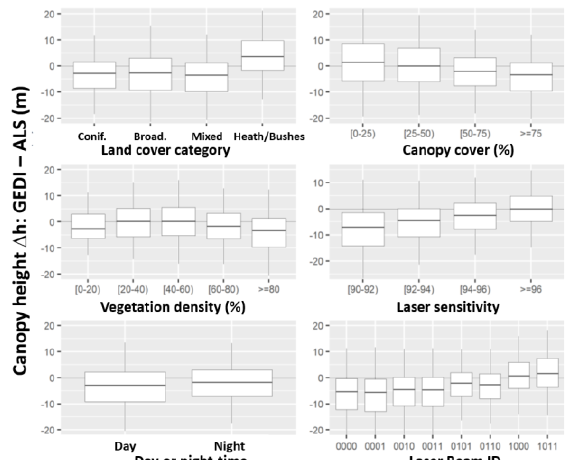
Figure 11. Error distributions of canopy height grouped by different variables.